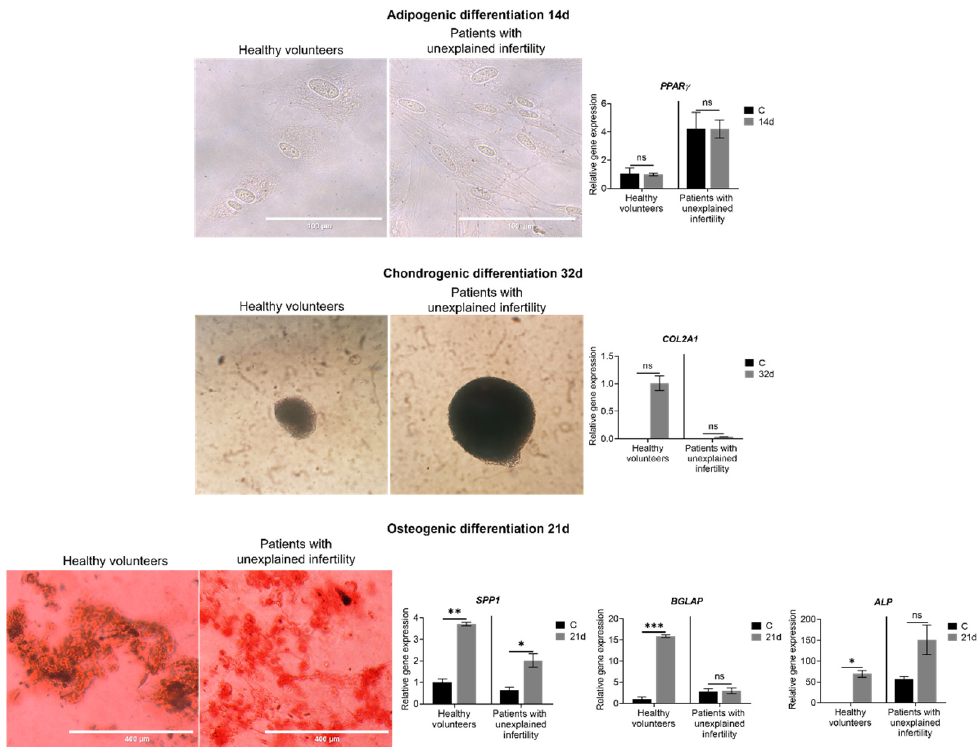
Figure 2. Morphology and expression of genes of MenSCs differentiated in adipogenic, chondrogenic and osteogenic directions. 14d—cells after 14 days of culture in differentiation medium, 32d—cells after 32 days of culture in differentiation medium, 21d—cells after 21 days of culture in differentiation medium. Cells were stained with oil red for assessment of adipogenic differentiation and alizarin red for staining for osteogenic differentiation. Scale bars: 100 µm (40× objective) and 400 µm (10× objective). Gene expression results are presented as mean ± standard deviation. * p ≤ 0.05; ** p ≤ 0.01; *** p ≤ 0.001; ns—not statistically significant, based on t -test.